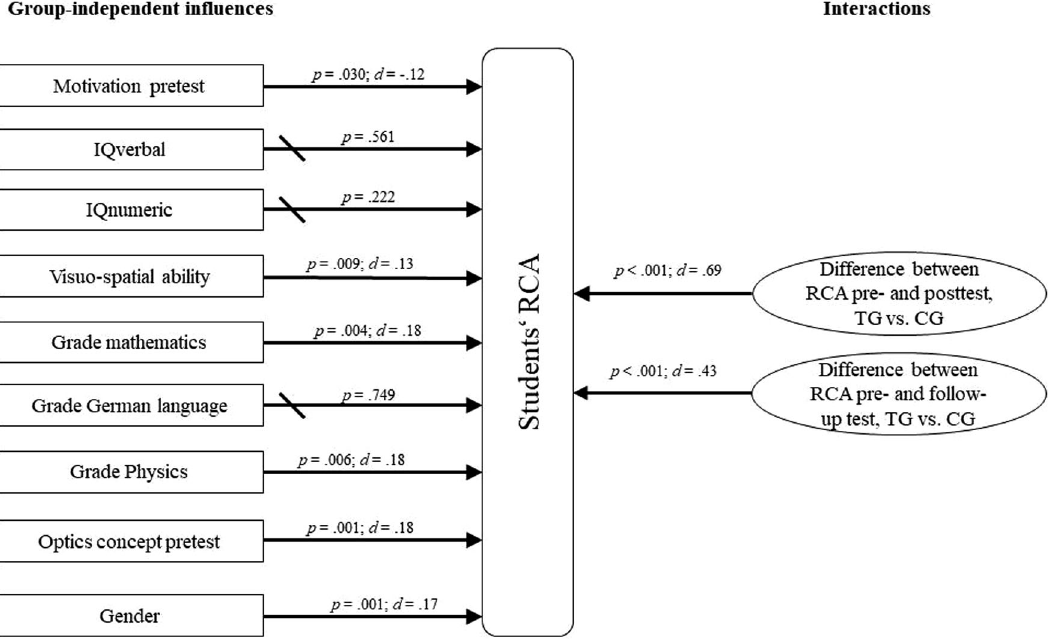
FIG. 5. Influence of variables on students ’ RCA, (multilevel model for measuring